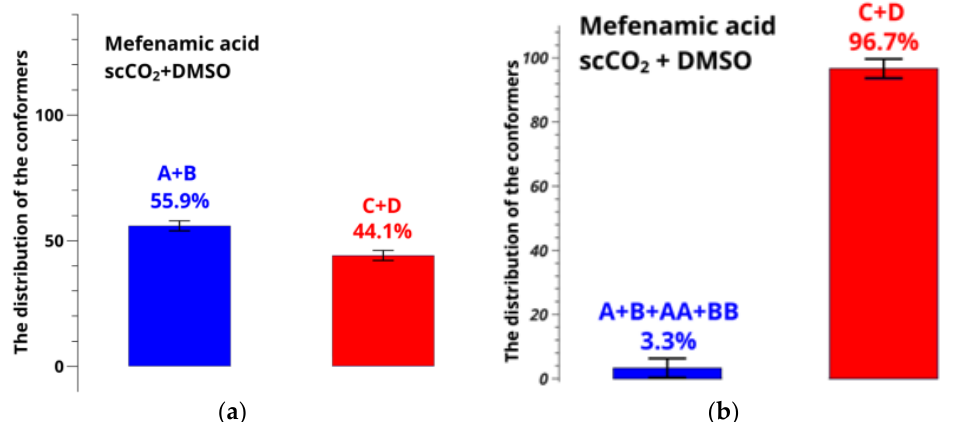
Figure 10. Distribution of conformers of MFA in scCO 2 + DMSO-d 6 at 9 MPa calculated from the observed conformation-dependent distance OH-H6 ( a ) without and ( b ) allowing for the existence of additional conformers AA and BB.